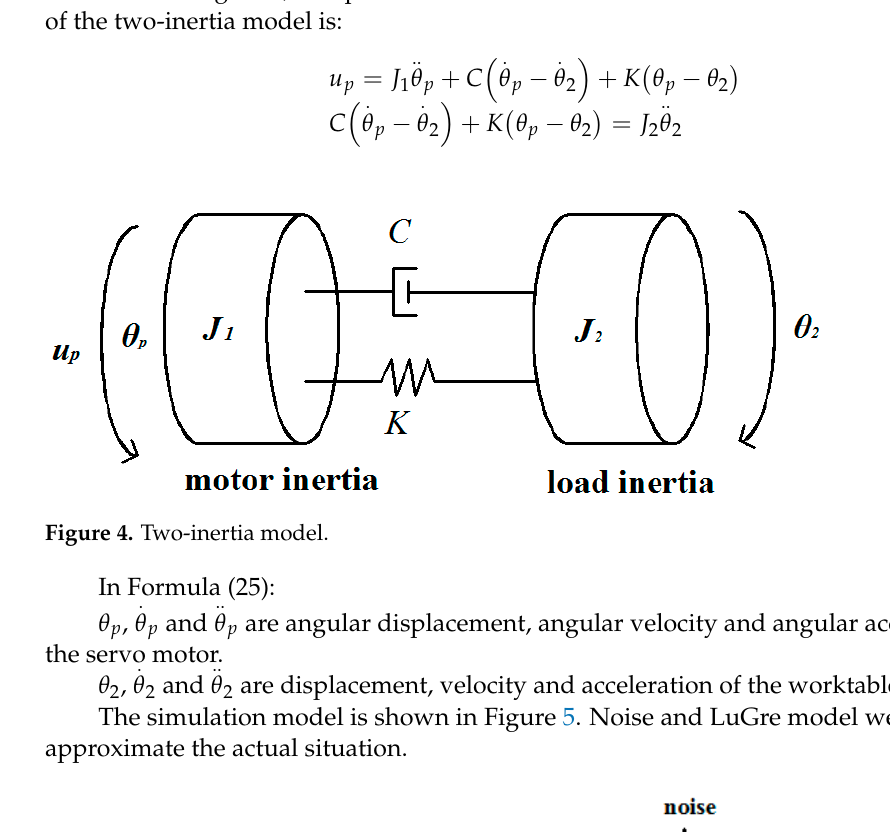
Figure 4. Two-inertia model.